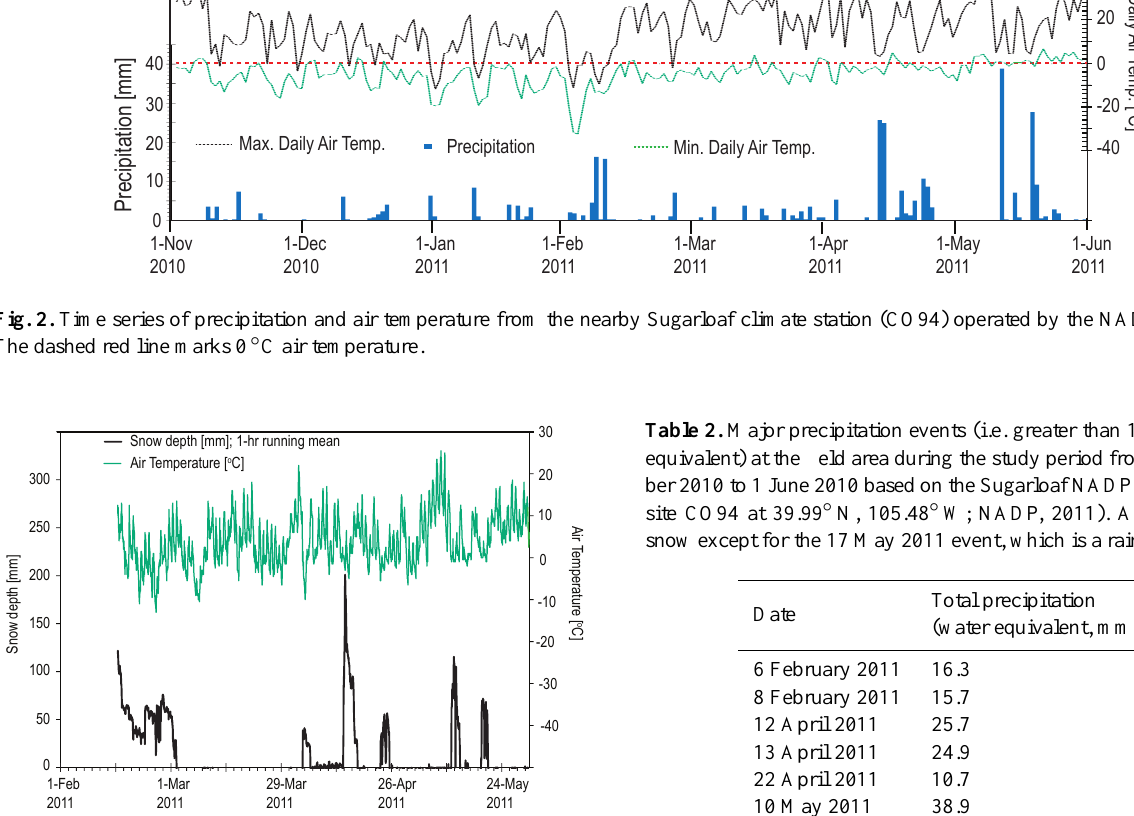
Fig. 3. Time series of snowdepth and air temperature from the ul- trasonic sensor at the north-facing midslope (NFM) plot.